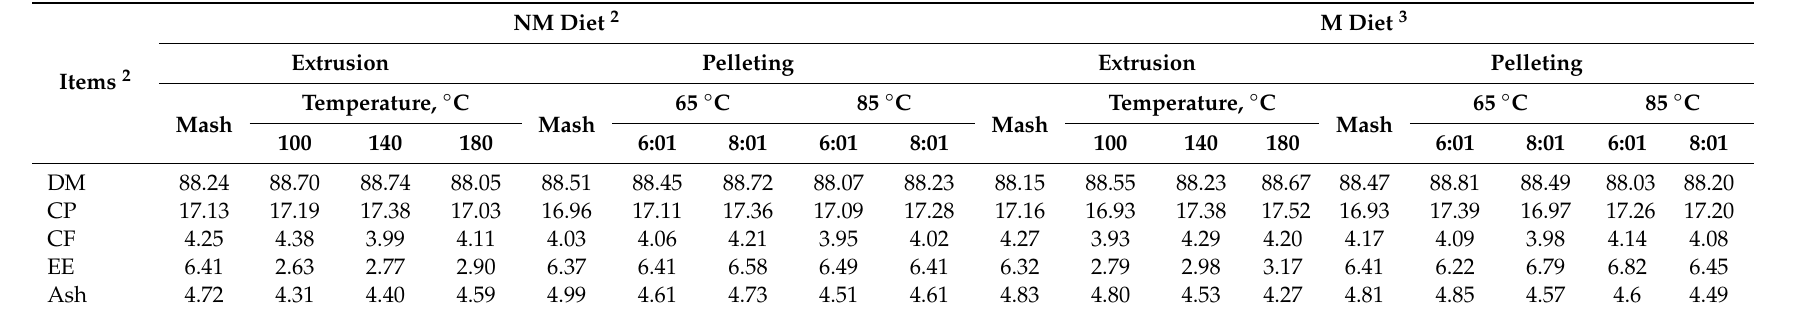
Table 3. Analyzed nutrient concentration in manufacturing productions (%, as-fed basis) 1